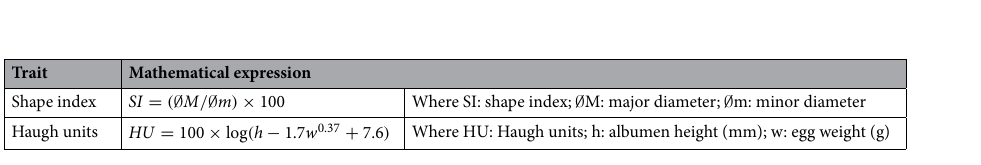
Table 6. Mathematical description of the egg quality-related indices.